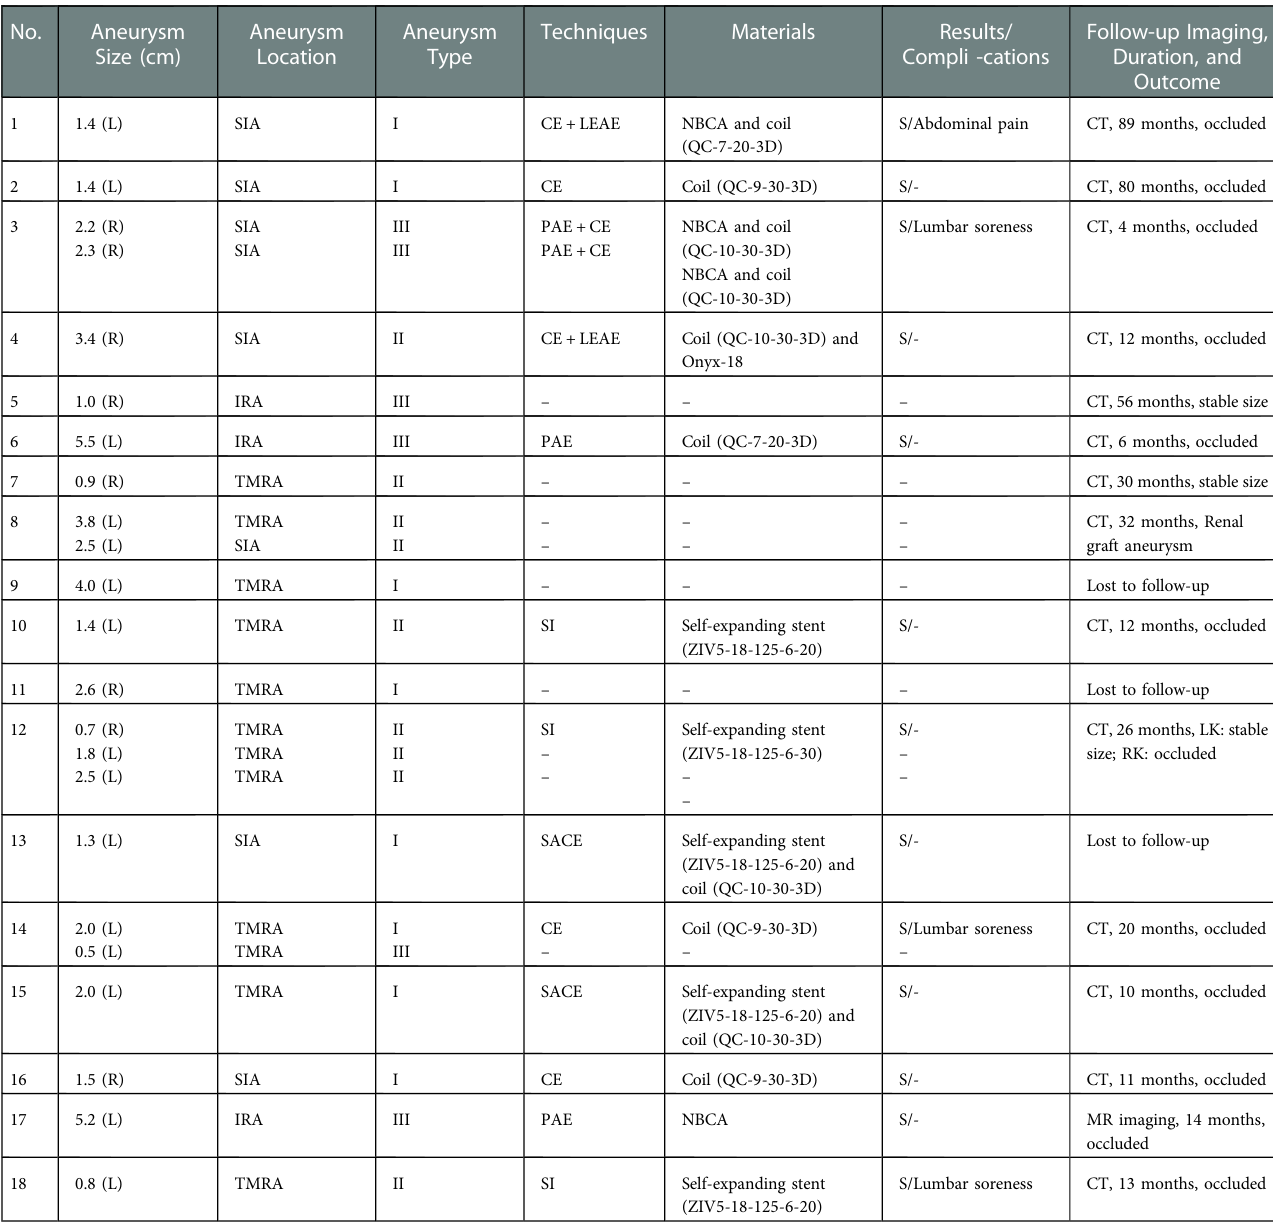
TABLE 2 23 aneurysms treatment parameters in 18